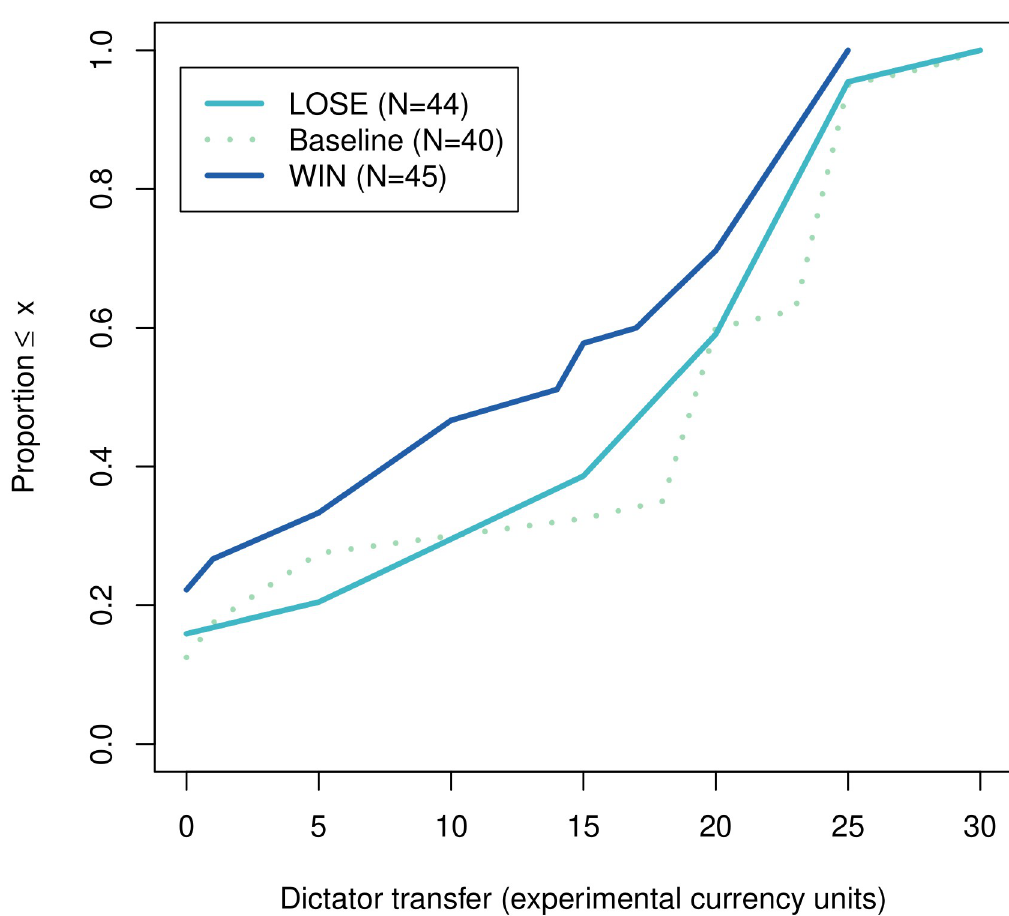
Fig 2. Empirical distribution function of the dictator transfer by treatment